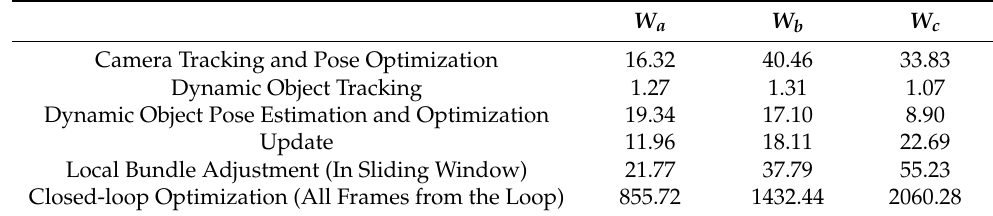
Table 1. Runtime (millisecond) statistics for important parts of 3D modeling processes for three objects W a , W b , W c .